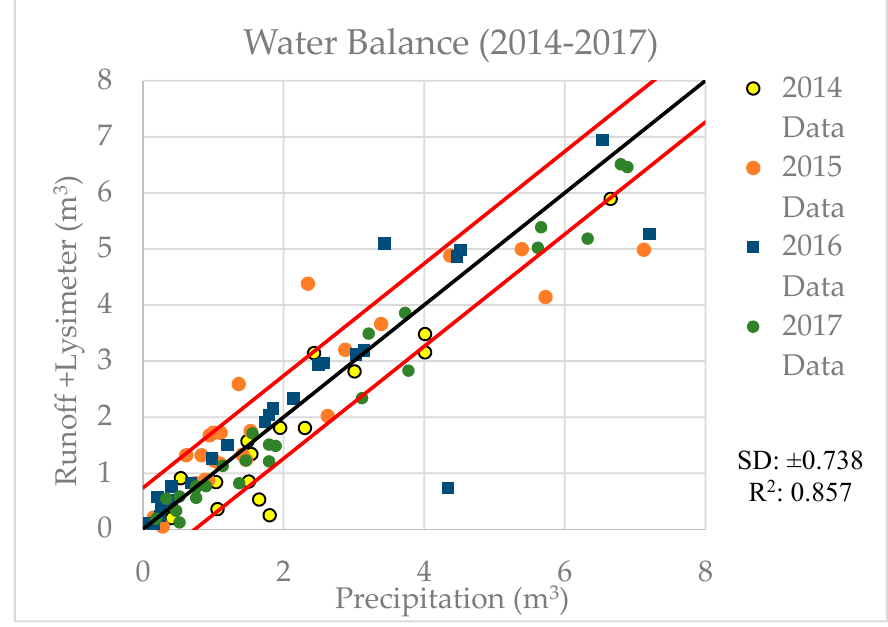
Figure 9. Water balance analysis (2014–2017).